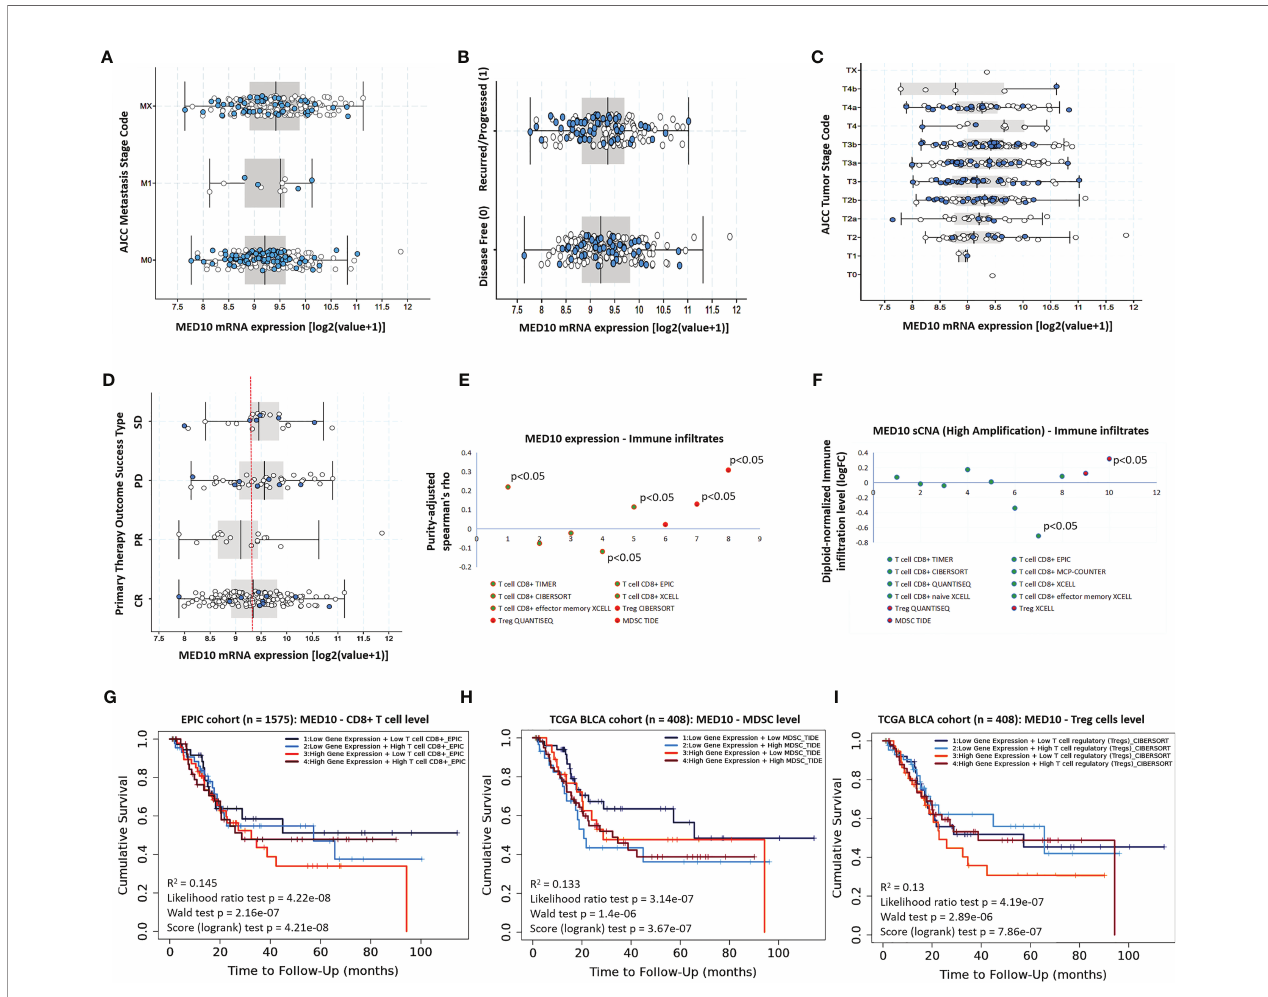
FIGURE 2 | MED10 expression is positively correlated with disease progression, immune suppression, and therapy failure. Box plots showing the association between MED10 mRNA expression and (A) AJCC metastasis stage, (B) recurrence/progression or disease-free status of patients, (C) AJCC tumor stage, or (D) primary therapy outcome success type, in the TCGA BLCA cohort. (E) Dot plot of the tumor purity-adjust correlation between MED10 expression and level of tumor immune in fi ltrates. (F) Dot plot of the effect of high ampli fi cation of MED10 on the diploid-normalized immune cell in fi ltration level. Kaplan – Meier plot showing the effect of altered MED10 expression with or without altered (G) CD8+ T, (H) MDSC, or (I) Treg cell level on the cumulative